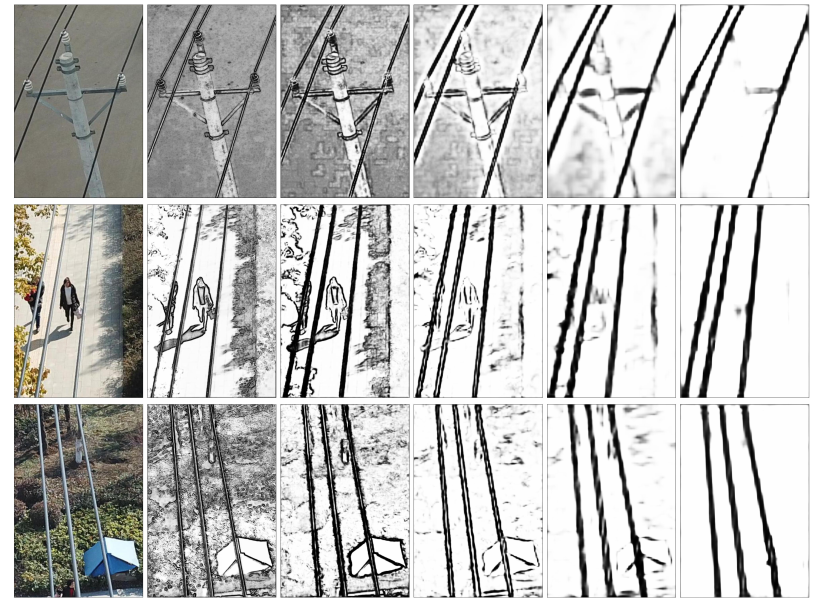
Figure 2. Some examples of the fine-to-coarse side outputs from the network. From left to right: the original inputs, the feature maps extracted from the first side output to the fifth side